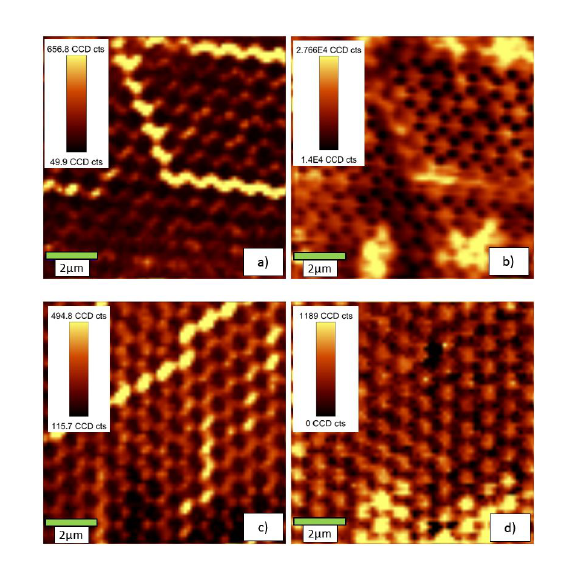
Figure 22: Representative fluorescence images (recorded at 614 nm) of samples without SiO x layer (a, b) and samples with a 10 nm SiO x layer deposited before spin coating with VTLUNP nanosuspensions (c,